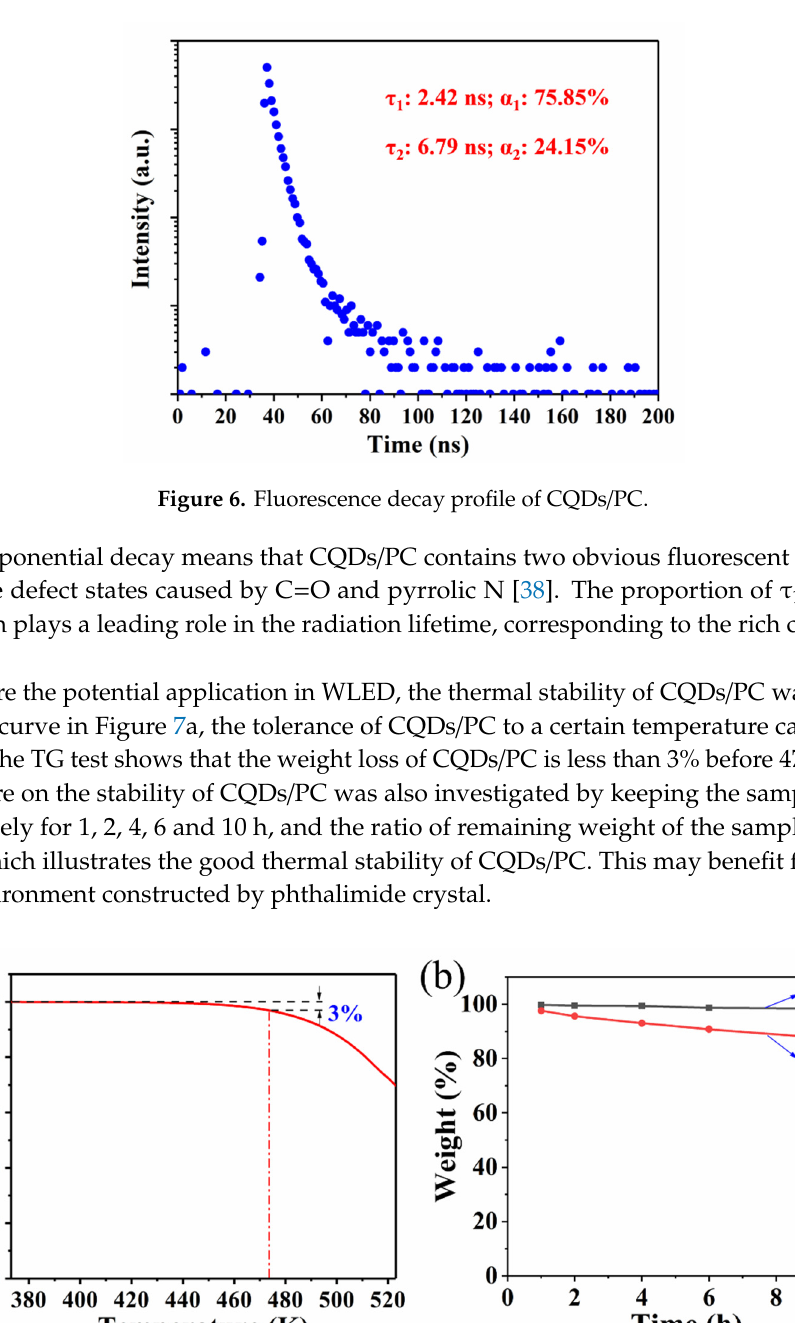
Figure 7. ( a ) Thermogravimetric (TG) curve of CQDs/PC phosphor. ( b ) Residual weight of CQDs/PC phosphor after keeping at 393 and 423 K with different times in air.